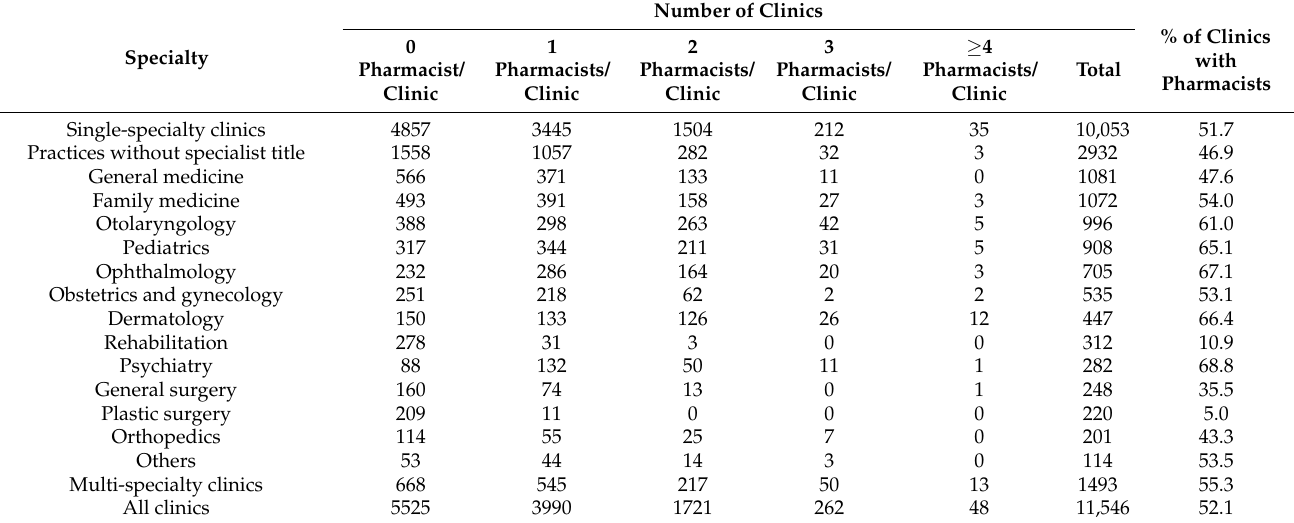
Table 2. Distribution of pharmacist workforce in clinics, stratified by